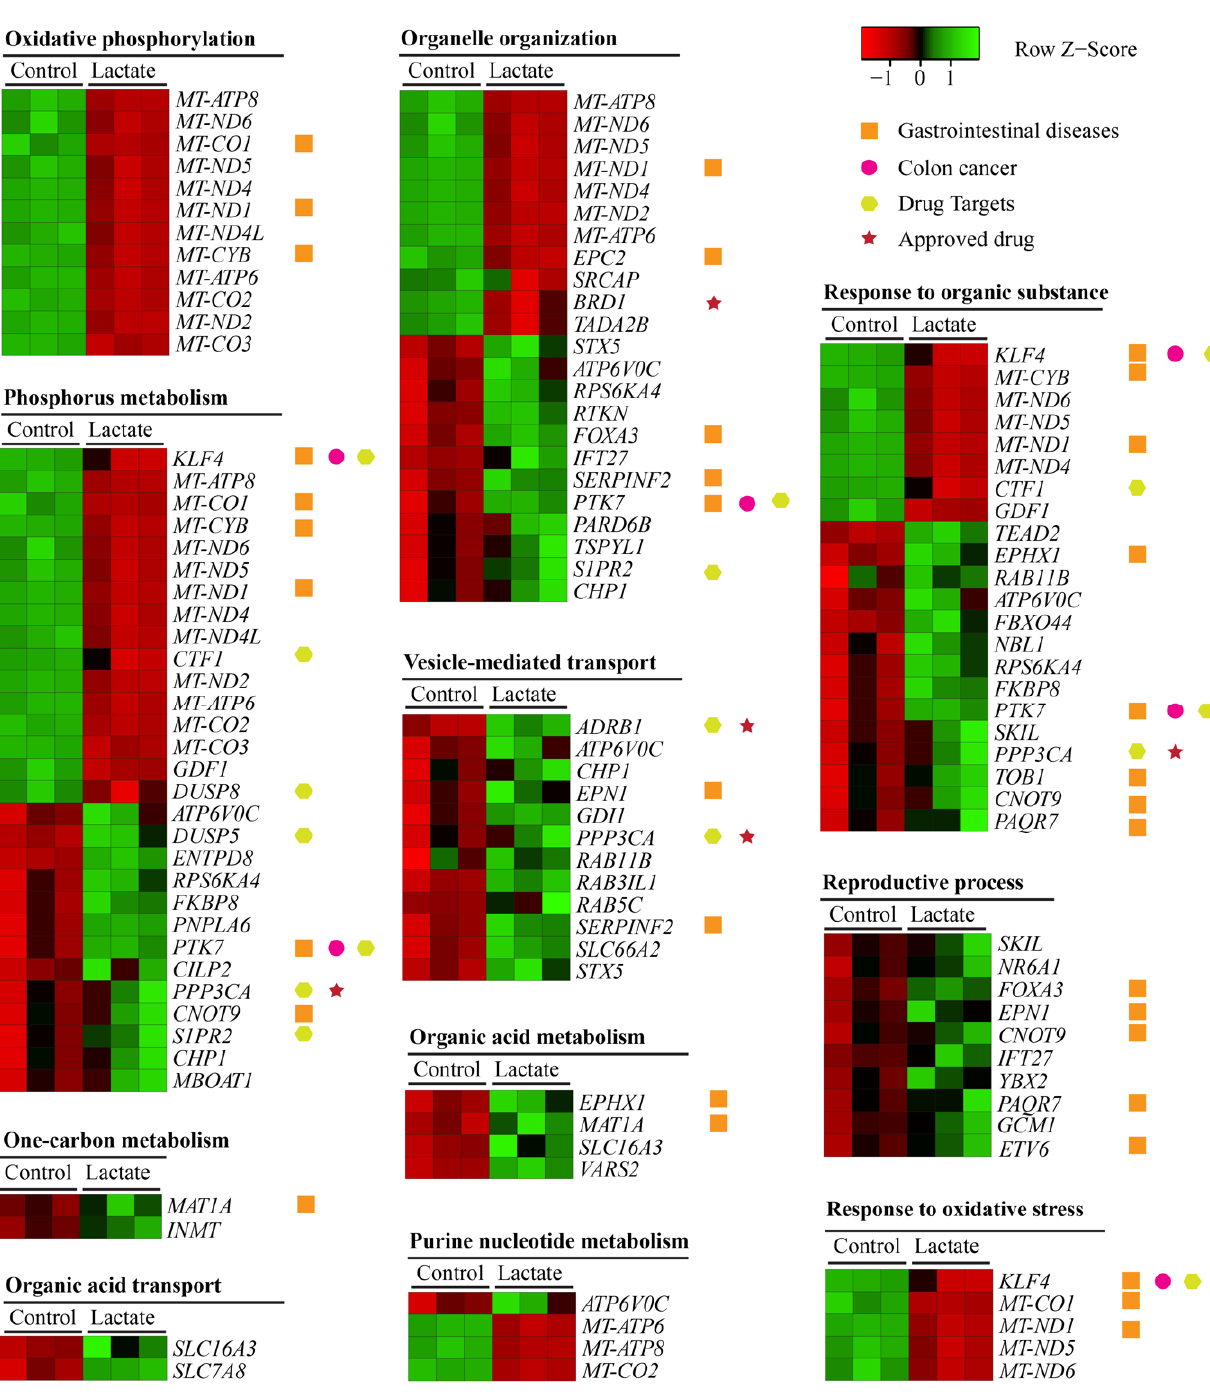
Figure 5. Supervised heat maps of genes in the enriched gene sets. The gene set enrichment analyses determined that the enriched gene sets and were performed using supervised hierarchical clustering in Heatmapper including DEGs with an FDR-corrected p < 0.05 and fold change ≥ 1.5, upregulated (red) gene, and downregulated (green) gene in the lactate vs. the control treatments.